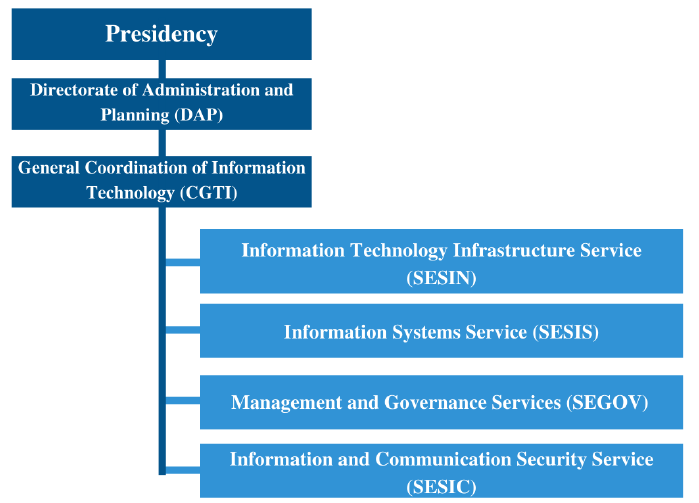
Figure 3. Structure of the General Coordination of Information and Communication Technology (CGTI)